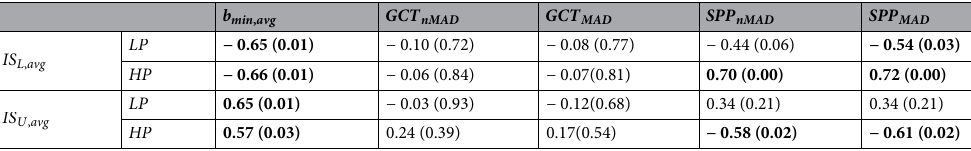
Table 2. The correlation coefficients between our proposed measures of stability and previously introduced biomechanical and variability measures. In each cell, the correlation coefficient and the p-value for testing the hypothesis of no correlation (in parentheses) are presented. Significant correlations (p-value < 0.05) are bolded. LP and HP stand for low-perturbation and high-perturbation walking conditions.